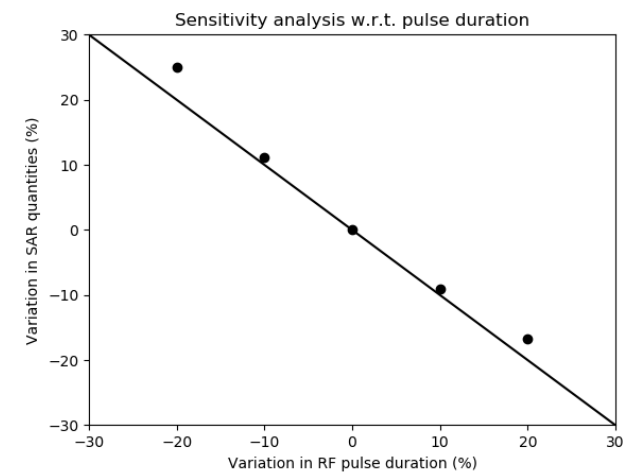
Figure 6. Relative variation in the estimated SAR quantities against relative variation in the RF